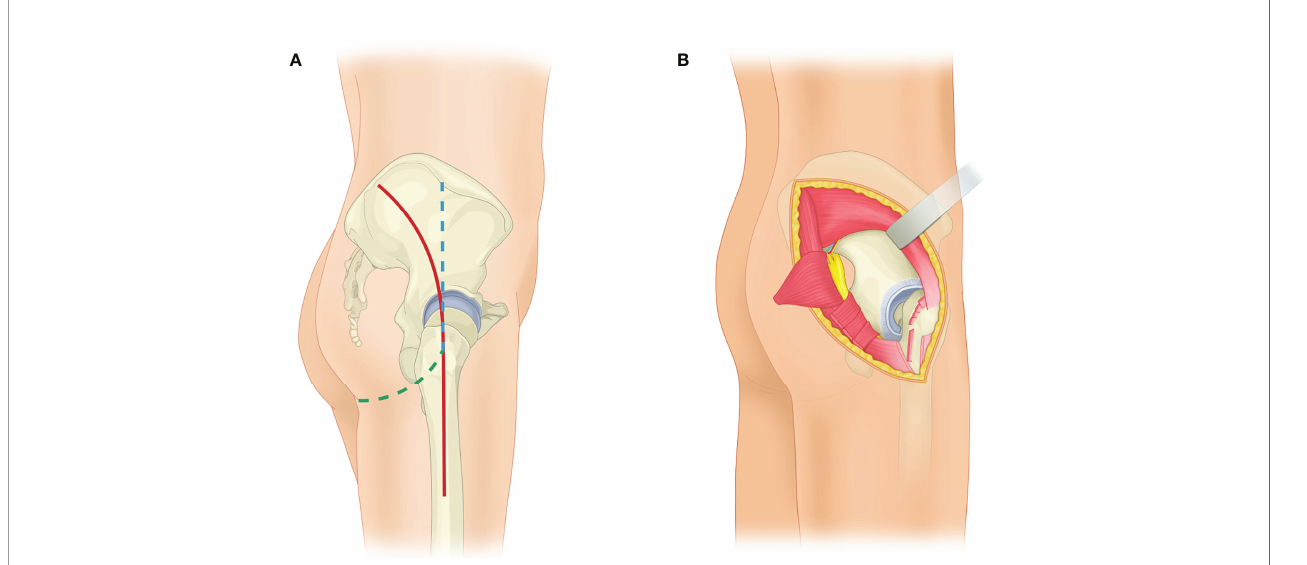
FIGURE 1 | Schematic depiction of the modi fi ed Gibson approach. (A) The routine Gibson approach (red) is shown. Both proximal and distal part of the approach can be modi fi ed according to tumor involvement. If majority of the anteroposterior ilium is under exposure, the proximal part of the modi fi ed approach (blue) would be used. Meanwhile, if the whole ischial tubercle was involved, the distal part of the incision (green) would be modi fi ed to follow the gluteus fold. (B) The image shows the exposure to the outer surface of the innominate bone via a modi fi ed Gibson approach. The femoral neck osteotomy and femur upshifting have been proceeded to relax the muscles, vessels, and nerves. The origin of the gluteus minimus is released and retracted with preserved gluteus medius proximally. The insertion of the gluteus maximus is released, and the gluteus maximus is retracted